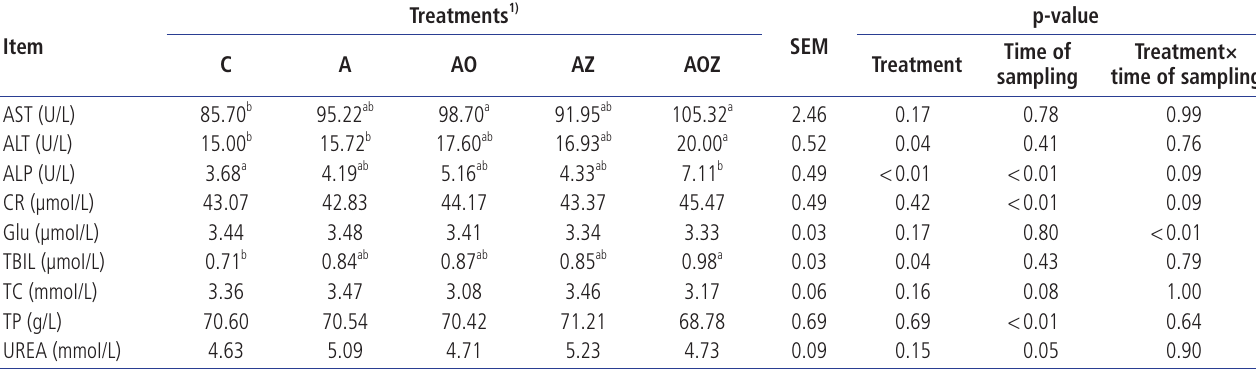
Table 4. Effects of AFB1, OTA, and ZEA on serum chemical parameters in dairy goats